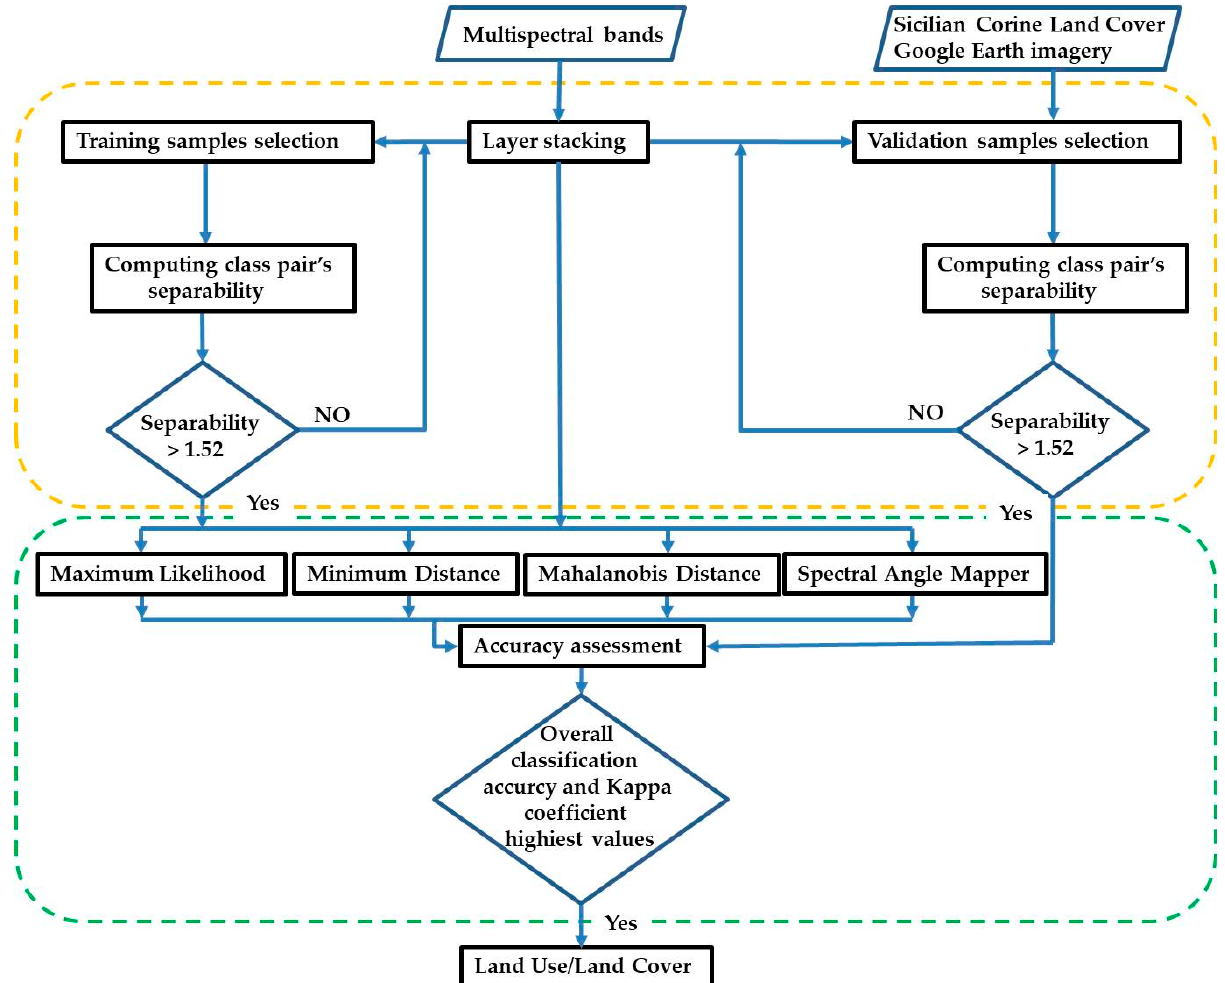
Figure 2. Flowchart of the methodology adopted for land use/land cover (LULC) mapping of PBs located on the coast of Messina province. The class pair separability is the value calculated for the possible combinations of 2 classes available for each